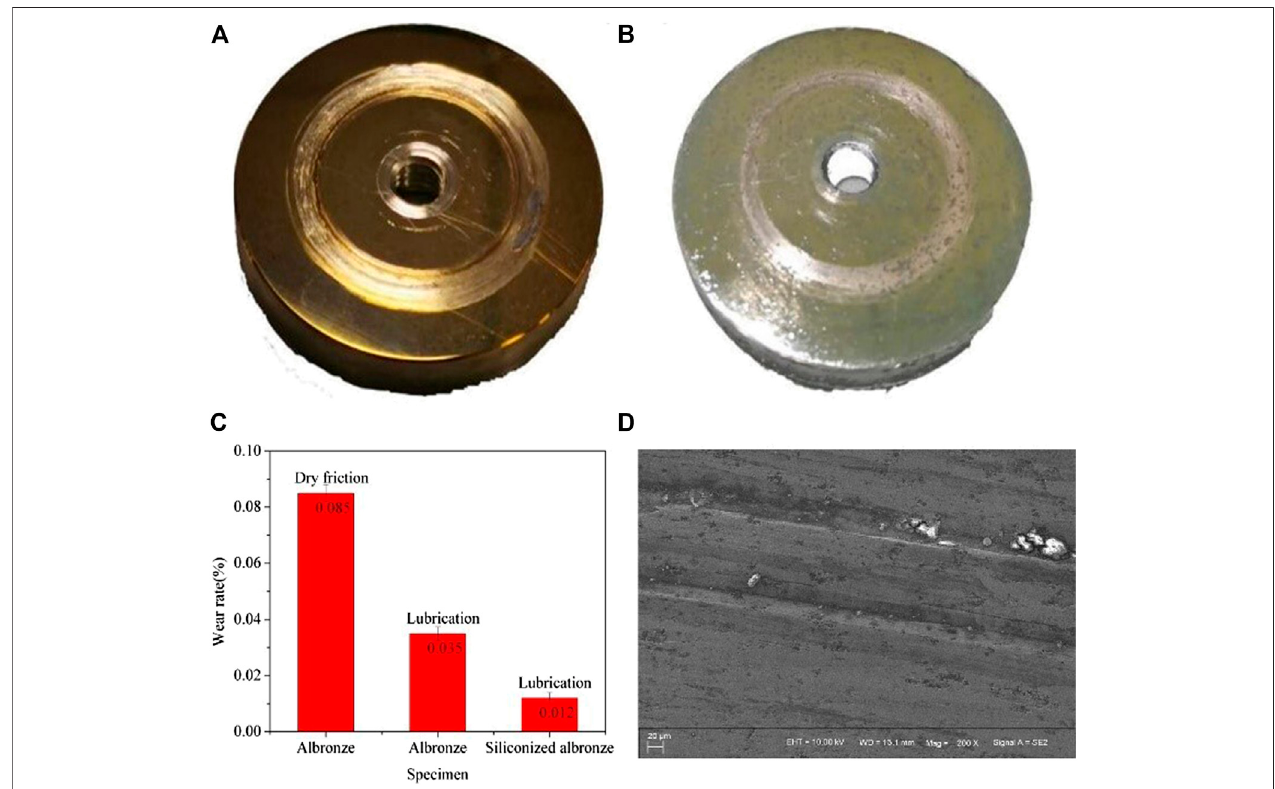
FIGURE5| Thescratchonthesurfaceoffrictionspecimen: (A) non-siliconizedsample; (B) siliconizedsamplealuminumbronzesample; (C) wearrate; (D) theSEM of the wear track.